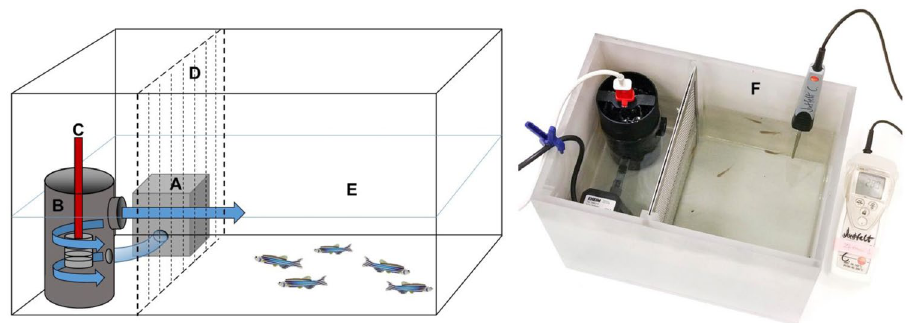
Figure 5. CT max experimental setup, ensuring homogeneous water temperature and consistent heating rate for all trials. ( A ) Water pump; ( B ) custom-made cylindrical steel heating case; ( C ) 300 W coil heater; ( D ) mesh (preventing fish swimming into the heating compartment); ( E ) fish compartment with 9 L of 28 °C water; ( F ) Photograph of the CT max